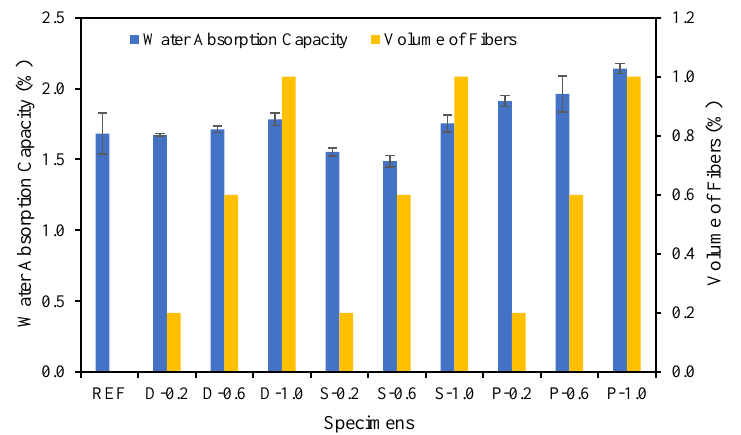
Figure 13. Different fibers influence on the water absorption capacity of fibrous concrete samples.